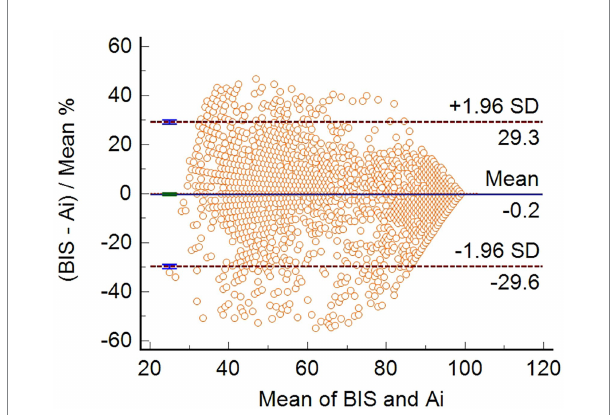
FIGURE 1 Bland–Altman consistency analysis between Ai and BIS. The bias (mean difference) between the Ai and BIS was-0.1747 (95% CI, − 0.6660 to 0.3166) ( n =